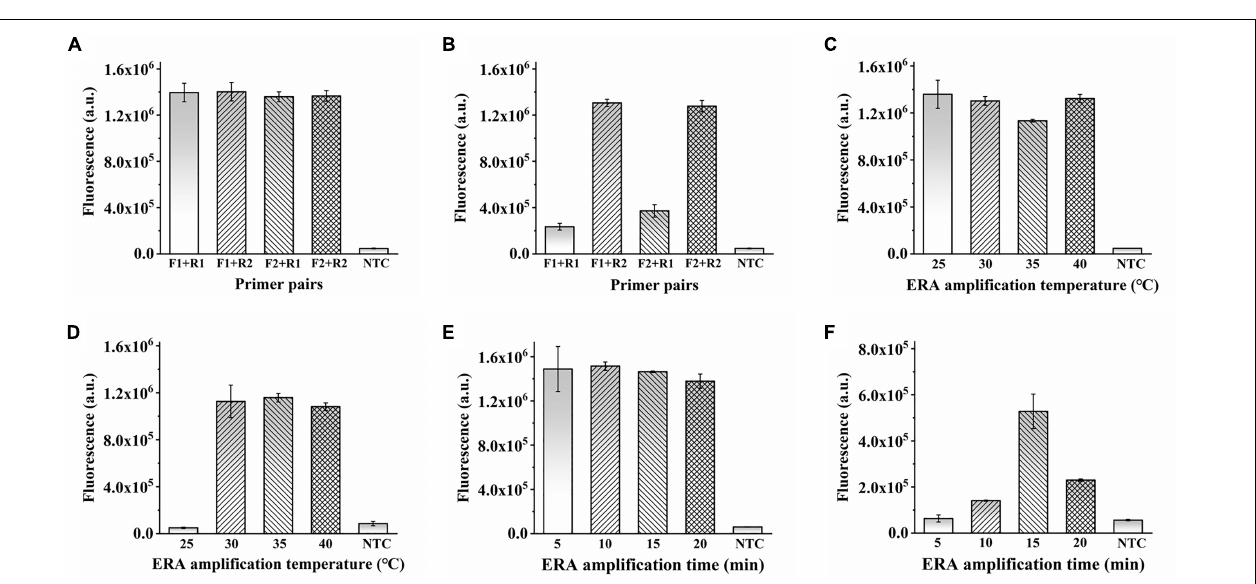
FIGURE 3 | Optimization of ERA in ERA/CRISPR–Cas12a fluorescence system. (A,B) Optimization of ERA primer. Template concentration: 10 7 copies/ µ L (A) , 10 5 copies/ µ L (B) . (C,D) Optimization of ERA temperature. Template concentration: 10 7 copies/ µ L (C) , 10 5 copies/ µ L (D) . (E,F) Optimization of ERA time. Template concentration: 10 5 copies/ µ L (E) , 10 2 copies/ µ L (F) . Error bars in panels represent the mean ± SD, where n = 3